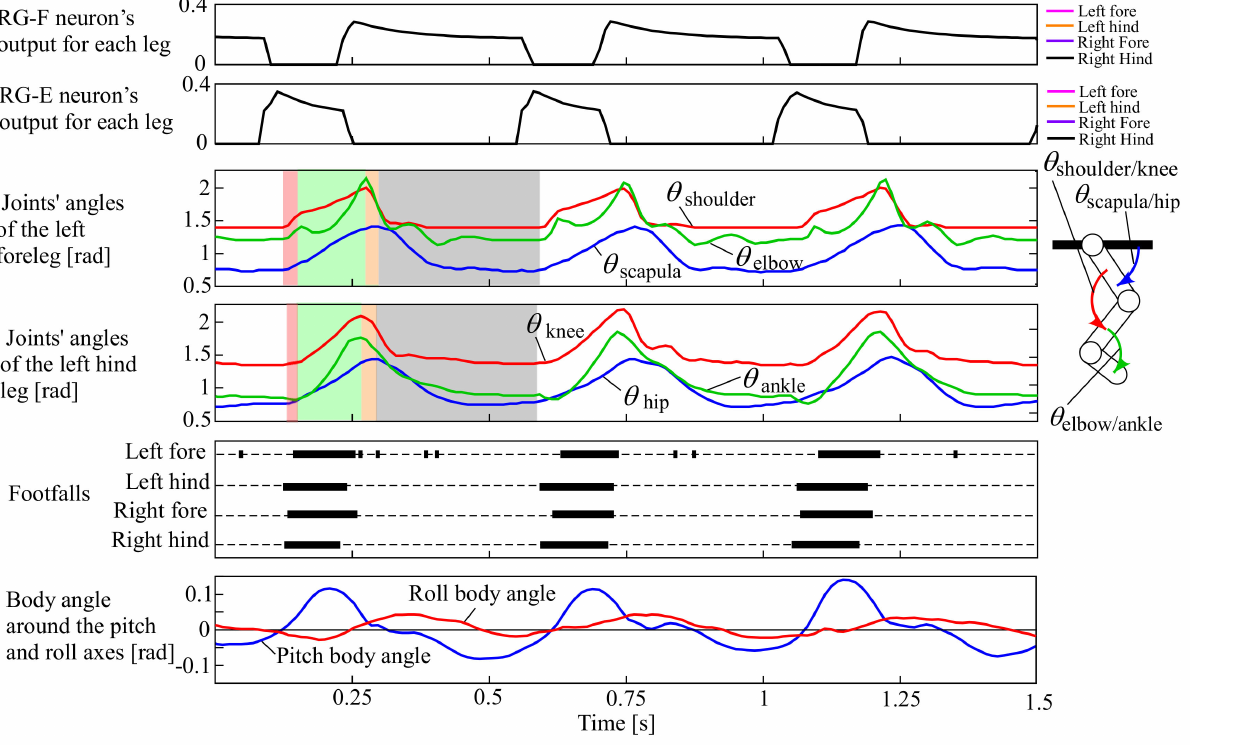
Figure 8. Experimental results of the pronk running of our quadruped robot, which include the outputs from the RG flexor (RG-F) and RG extensor (RG-E) neurons for the four legs, the joints’ angles of the left fore and hind legs (the origin and orientation are shown in the leg diagram), the footfalls for the four legs (thick lines represent the stance phases), and the body angles around the pitch and roll axes (positive when tilted forward and rightward, as shown by white arrows in 1 (cid:13) of Figure 7). In Figure 8, the outputs from RG-F and RG-E were exactly in phase between the four legs (i.e., the plots for the four legs exactly overlapped). As a result, the four legs similarly moved, as shown in the joints’ angles of the left fore and hind legs, and each leg performed the touch-down, stance, lift-off, and swing motions in order in the transparent red,